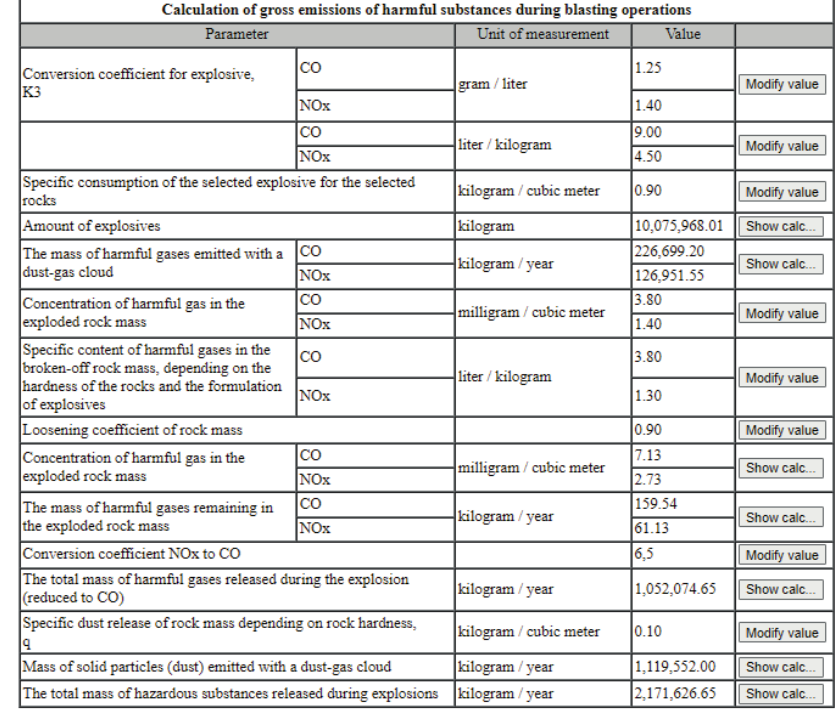
Fig. 3. Calculation of gross emissions of harmful substances during blasting operations.